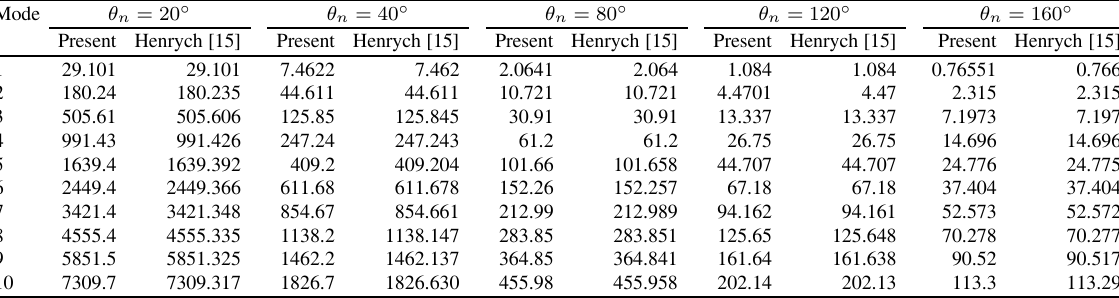
Table 9 Dimensionless natural frequencies of a clamped-free uniform